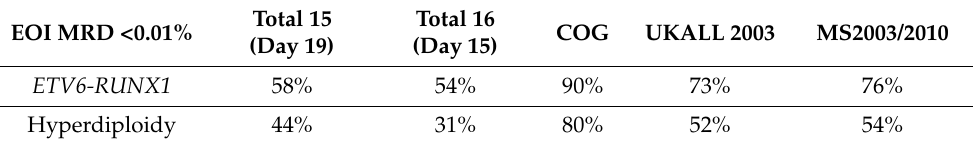
Table 2. EOI MRD response in favorable-risk genetic risk subtypes. ETV6-RUNX1 has the second most rapid MRD response among all the genetic subgroups after TCF3-PBX1